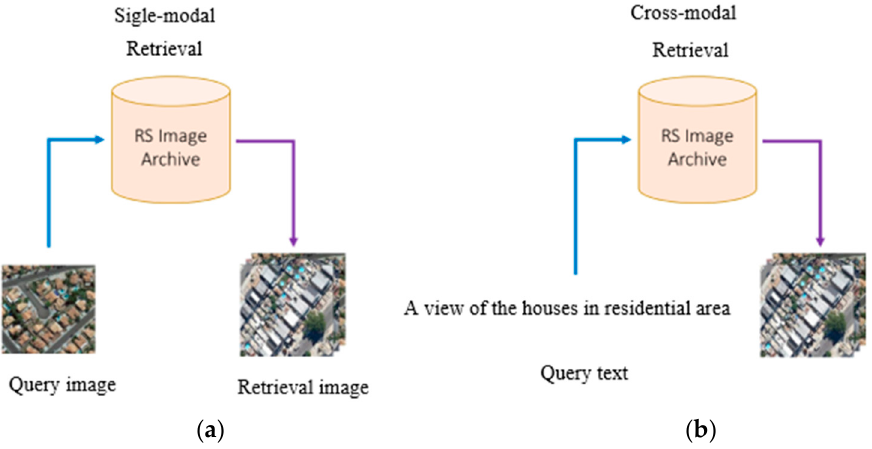
Figure 1. Content-based RS image retrieval system: ( a ) single modal, ( b ) cross-modal.